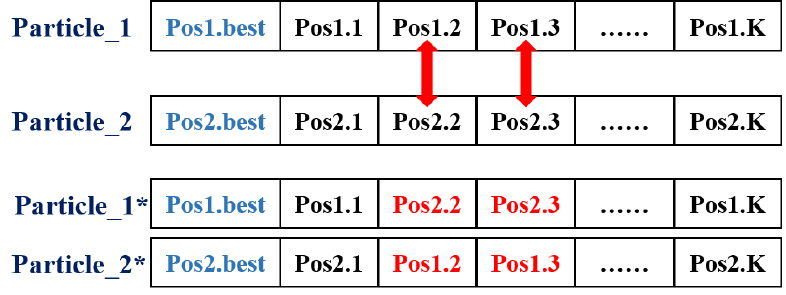
Figure 10. An example of crossover process.